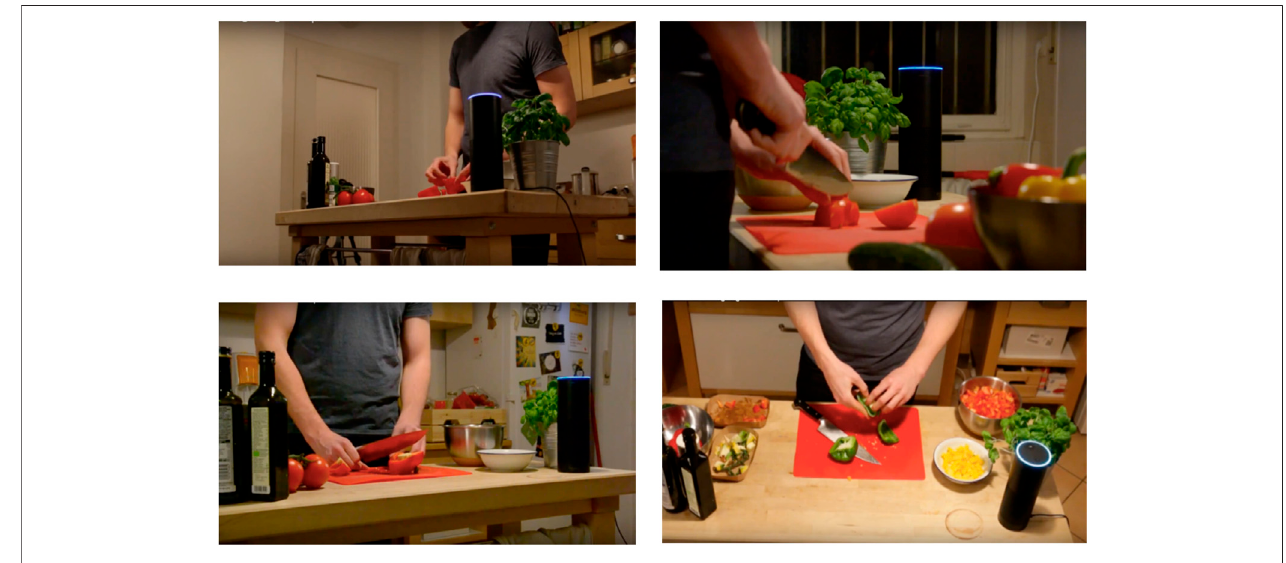
FIGURE 1 | Screenshots of the video the participants watched.